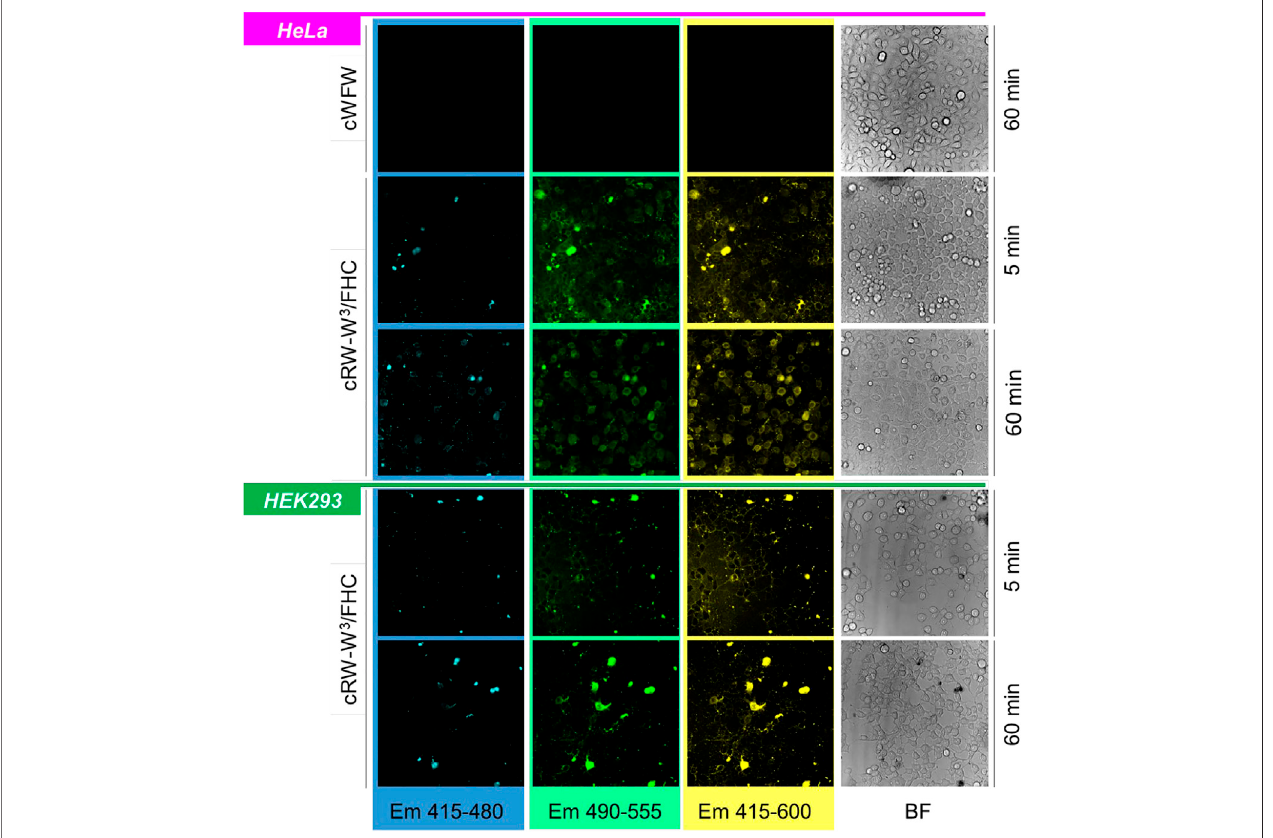
FIGURE 7 | Band- fi ltered confocal fl uorescence images of adherent HeLa and HEK293 cell cultures incubated with 30 µM cRW-W 3 /FHC for 5 and 60 min (indicated). Spectral ranges for collecting emission data are shown at the bottom of the image stacks; BF (cid:1) bright- fi eld images.